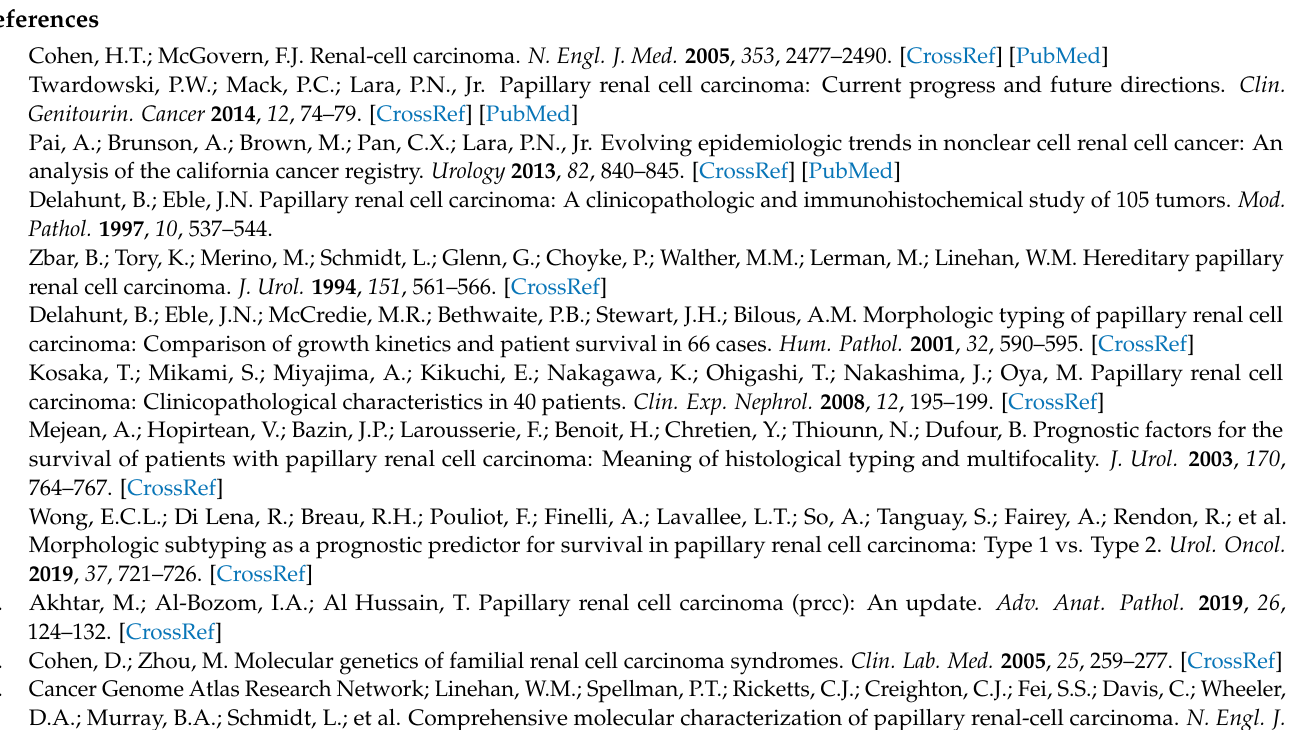
OIP5 expression; Table S6A: Overlap66 genes’ association with OS possibility and their oncogenic functions; Table S6B: Overlap21 and Overlap21plus gene